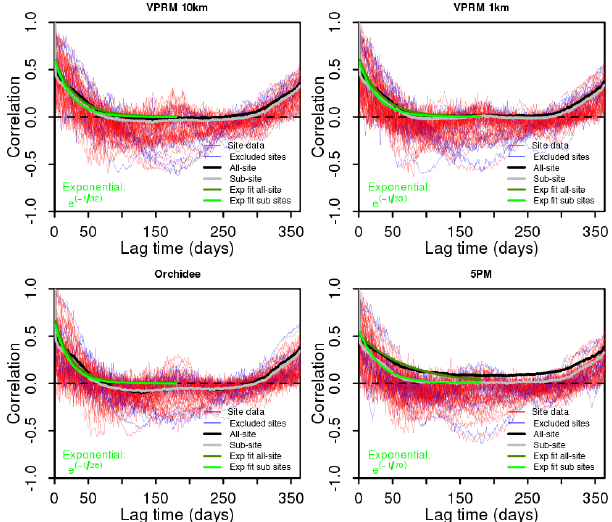
Figure 4. Temporal lagged autocorrelation from model–data daily averaged NEE residuals for all models. Thin red lines correspond to different sites, while the blue thin lines reveal the sites with a bias larger than ± 2.5µmolm − 2 s − 1 . The thick black line shows the all-site autocorrelation, and the thick grey line indicates the all-site autocorrelation but for a subset that excludes sites with large model– data bias (“sub-site”). The dark green line is the all-site exponential fit, and the light green line shows the all-site autocorrelation exclud- ing the sites with large bias. The exponential fits use lag times up to 180